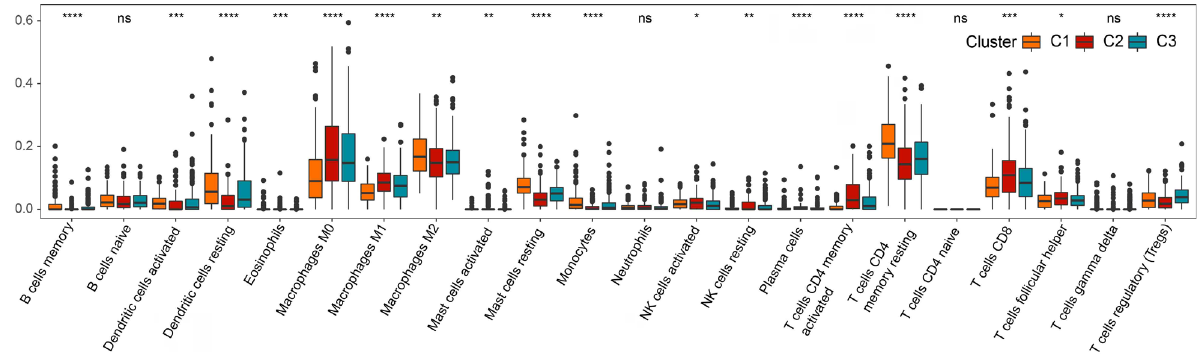
Figure 4 – Comparison of immune infiltration scores among the 3 clusters. Immune infiltration scores of the 3 clusters estimated using